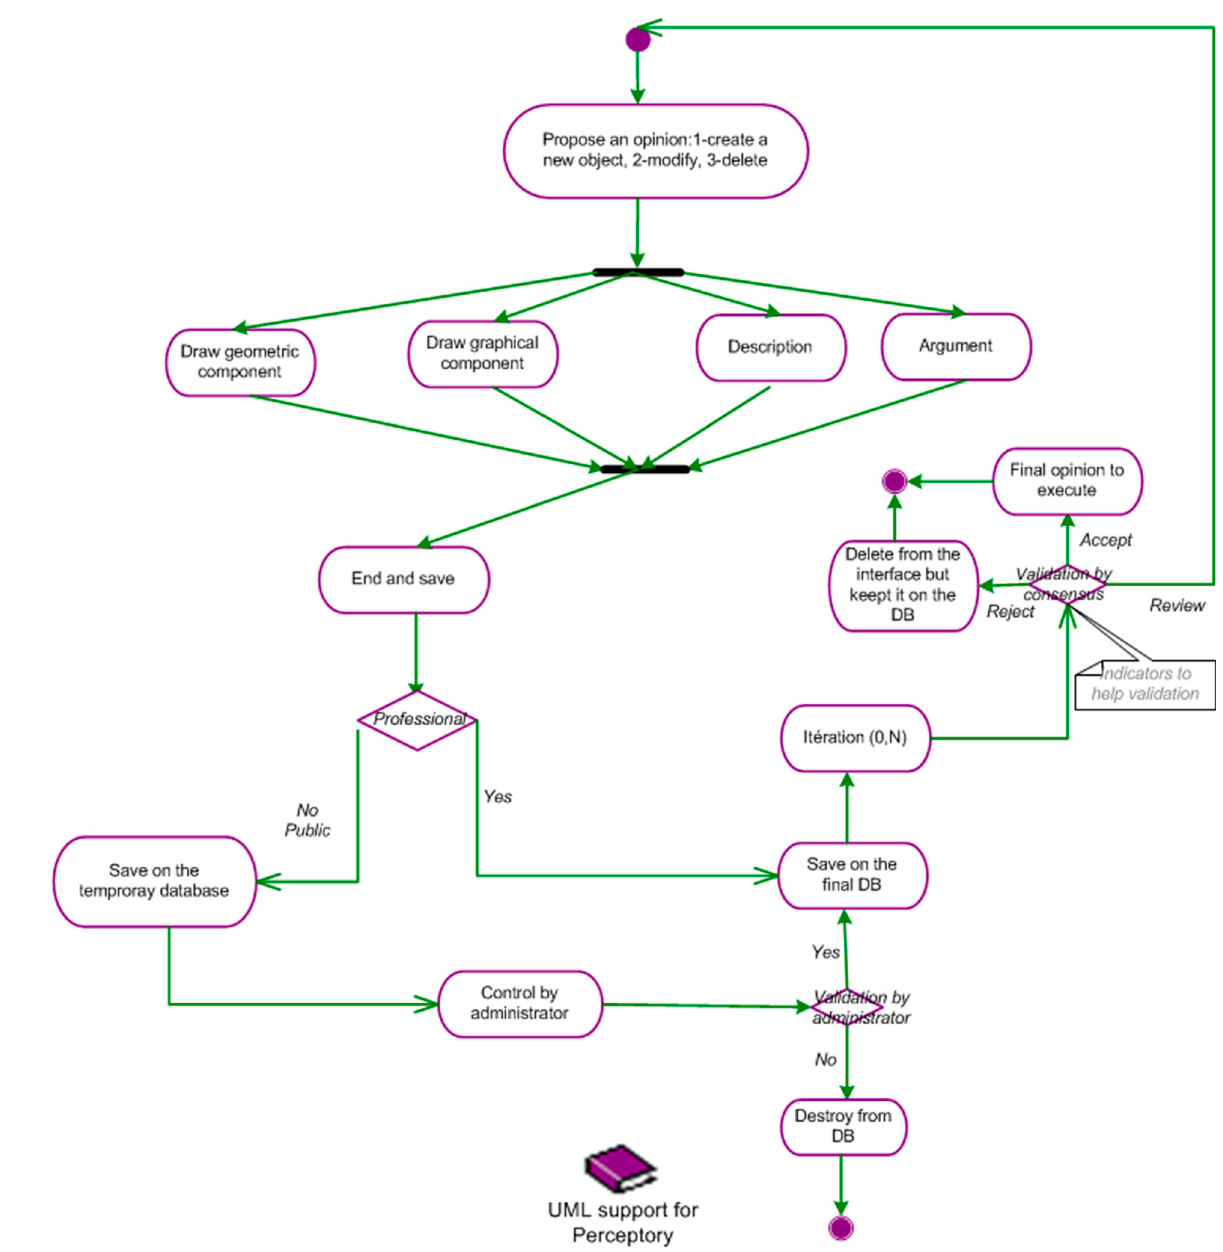
Figure 16. Activity diagram: Life process of